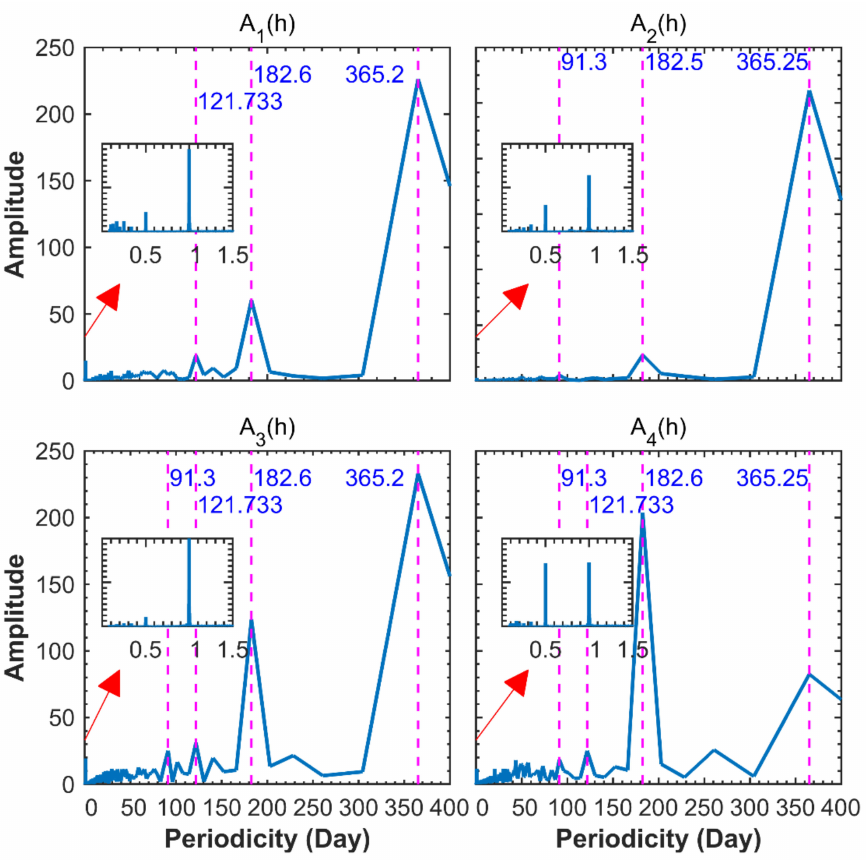
Figure 2. Spectral analysis of the four orders correlation coefficients from 2015 to 2019. The block in the figure represents a short-time power spectrum. The blue font represents the period corresponding to the high-power